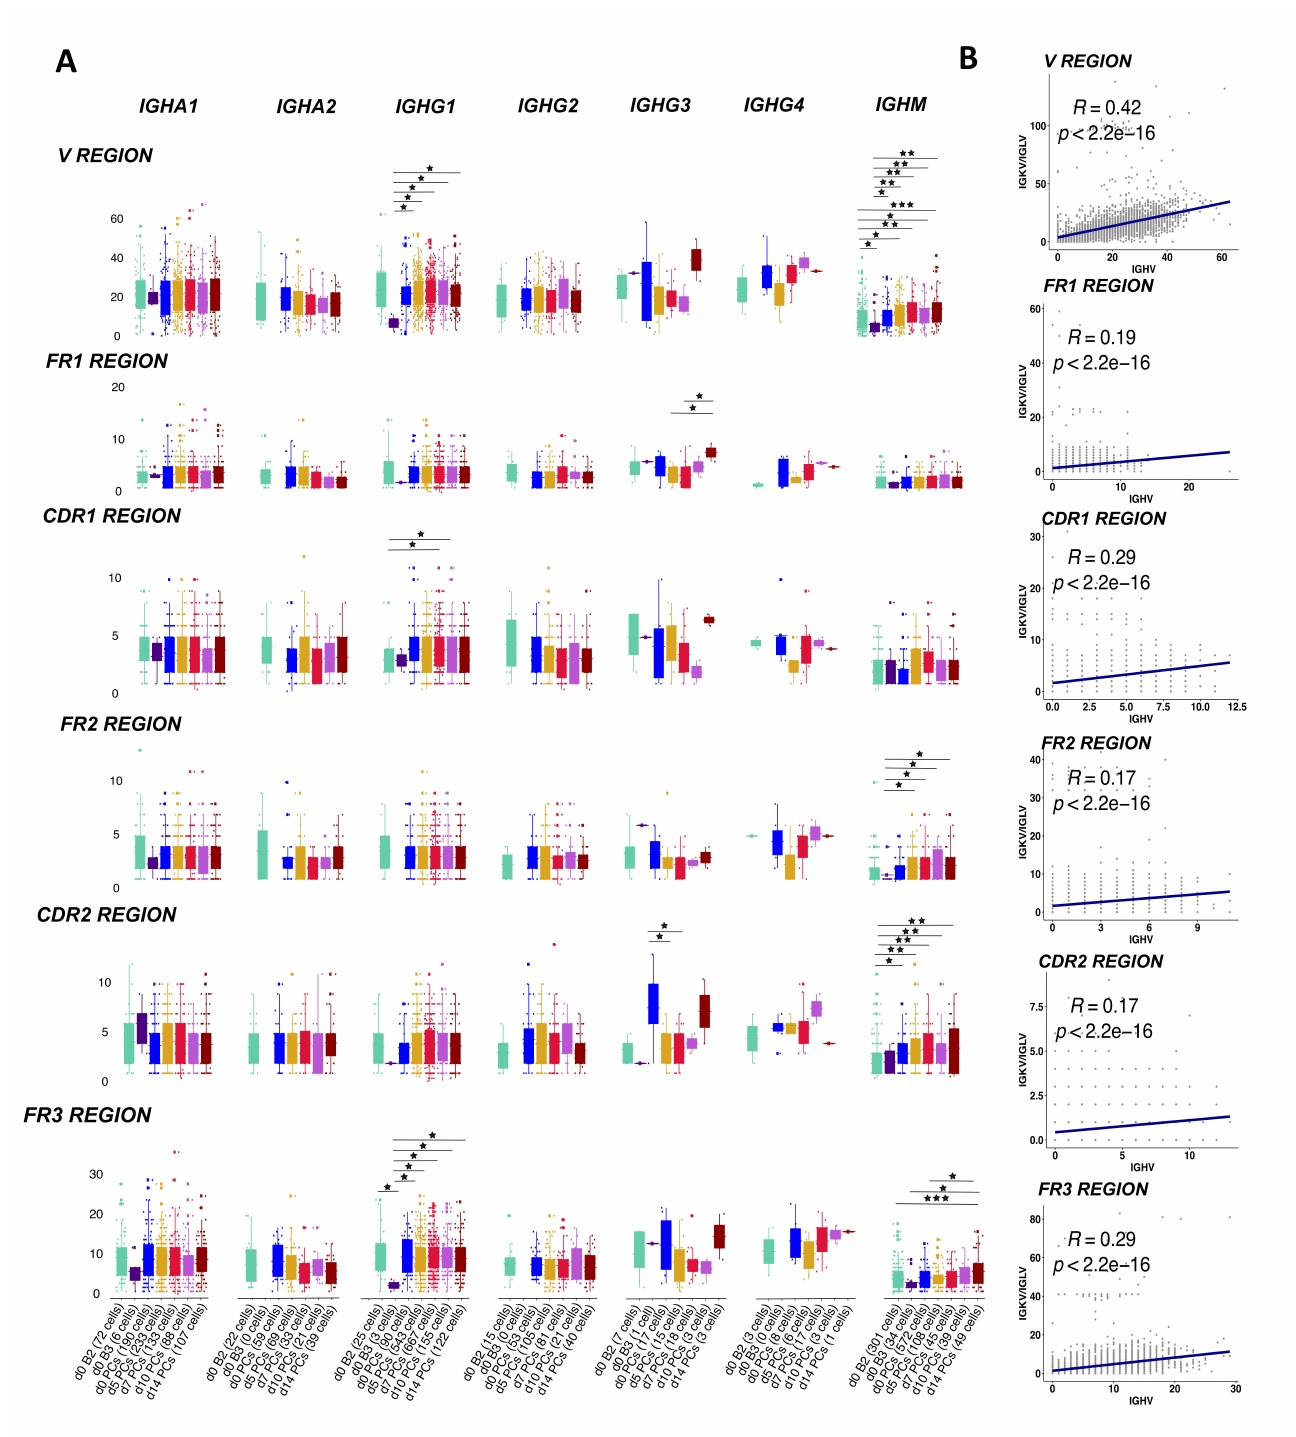
Figure 6. SHM levels in the V genes in heavy and light chains. ( A ) The boxplot representing the number of mutations in the V genes of BCRs over different time-points pre- and post-vaccination per different constant gene. The mutations have been identified in each cell over framework and complementarity determining regions in the V region. The cells at d0 are divided over naive B cells, memory B cells, activated memory B cells and PB/PCs. Each dot is a sequence from a single cell. The significant mean differences as calculated by the t-test are highlighted by asterix as *: 0.05–0.01, **: 0.01–0.001 and *** < 0.001. ( B ) The correlation of mutation numbers in all the V regions between heavy and light variable genes for all cells with known paired constant BCRs. The regression line is fitted and the correlation and p values are indicated on